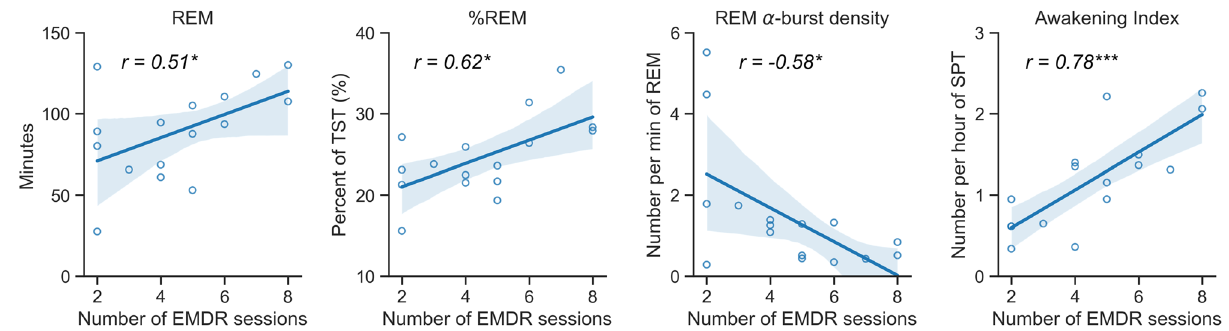
Figure 2. Significant correlations between number of EMDR sessions before remission and sleep parameters before therapy. *p < 0.05, ***p <